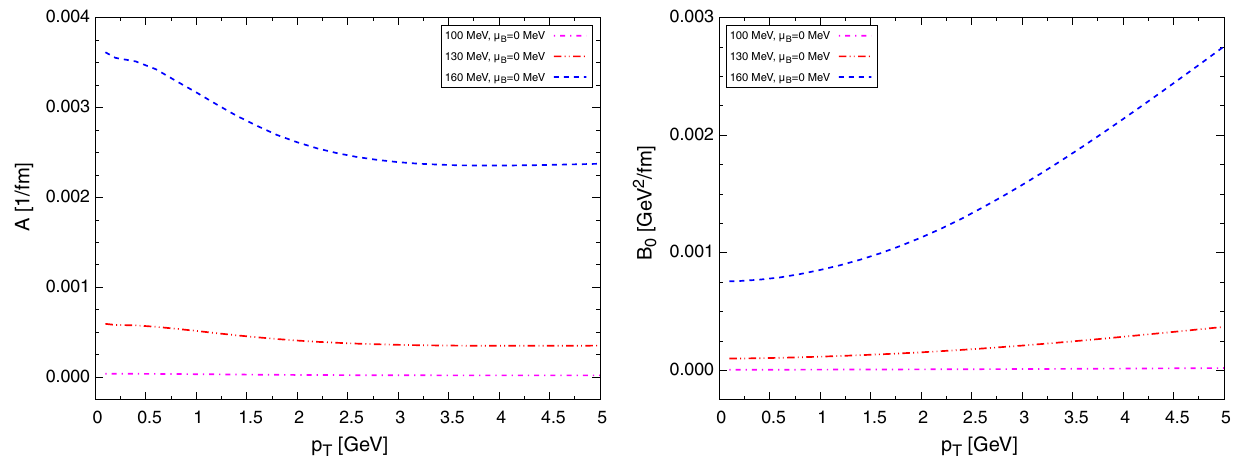
Fig. 4 Drag (left) and diffusion (right) coefficients at different temperatures for D mesons interacting with baryons N and (cid:11)